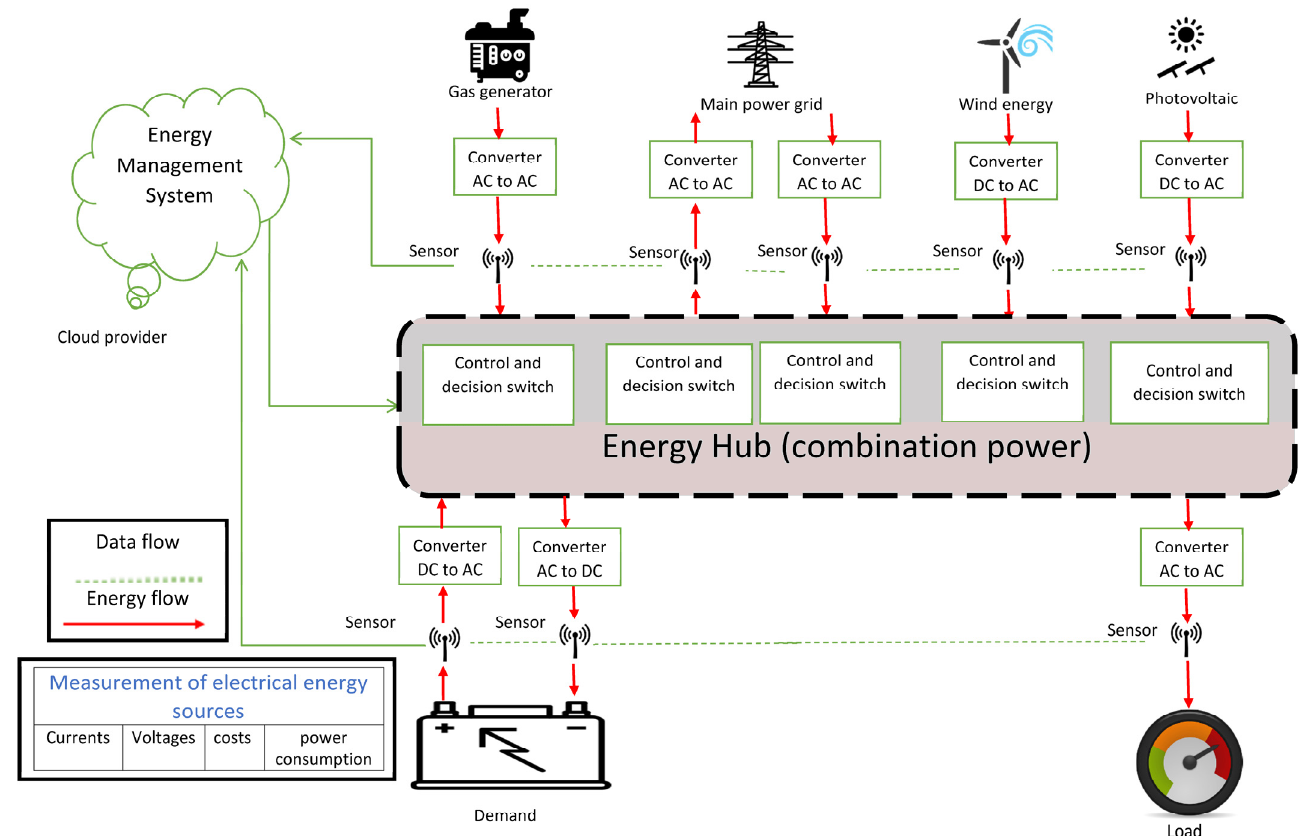
Figure 9. The framework system model for energy sustainability.